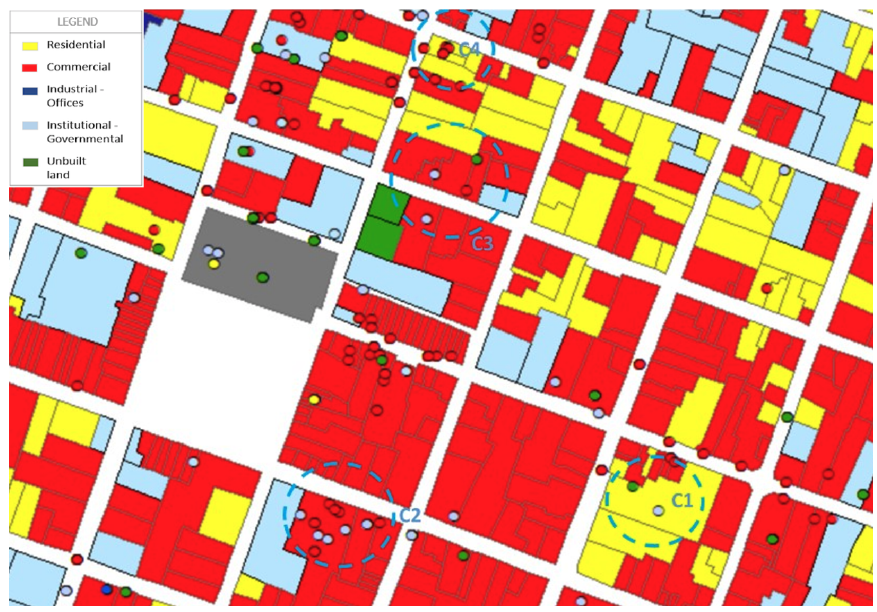
Figure 6. Example of inconsistency between the categorization of the cadastre and the result obtained by the